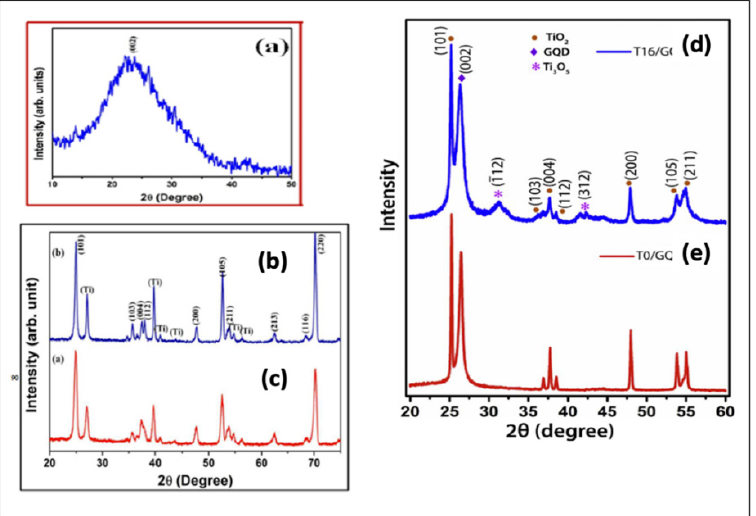
Figure 16. XRD patterns of GQDs, TiO 2 , and TiO 2 -GQD nanocomposites. ( a – c ) reproduced from [93] with permission from The Royal Society of Chemistry. ( d , e ) reprinted with permission from [107] Copyright 2018 Elsevier.